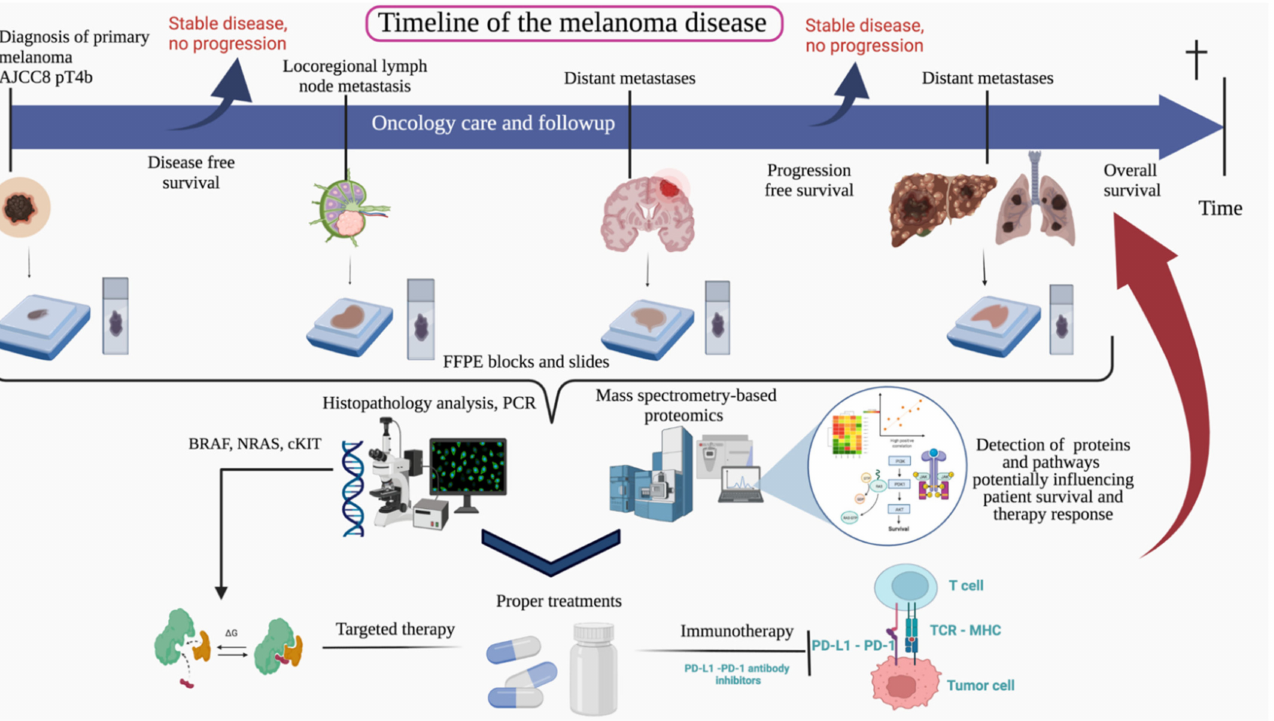
Figure 1. The overview of our study. Scheme illustrating the general working process of our study, showing the timeline of the melanoma disease, from the tumor diagnosis, through progression until the appearance of the distant metastases. This study included 90 FFPE melanoma samples collected during the oncology care and follow-up. The collected samples were submitted for histopathology and protein analysis by high-resolution mass spectrometry. Proteins and pathways were detected indicating survival and therapy